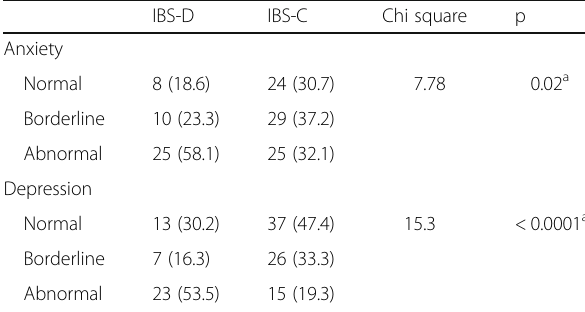
Table 6 Comparison between IBS subtypes as regards depression and anxiety scores